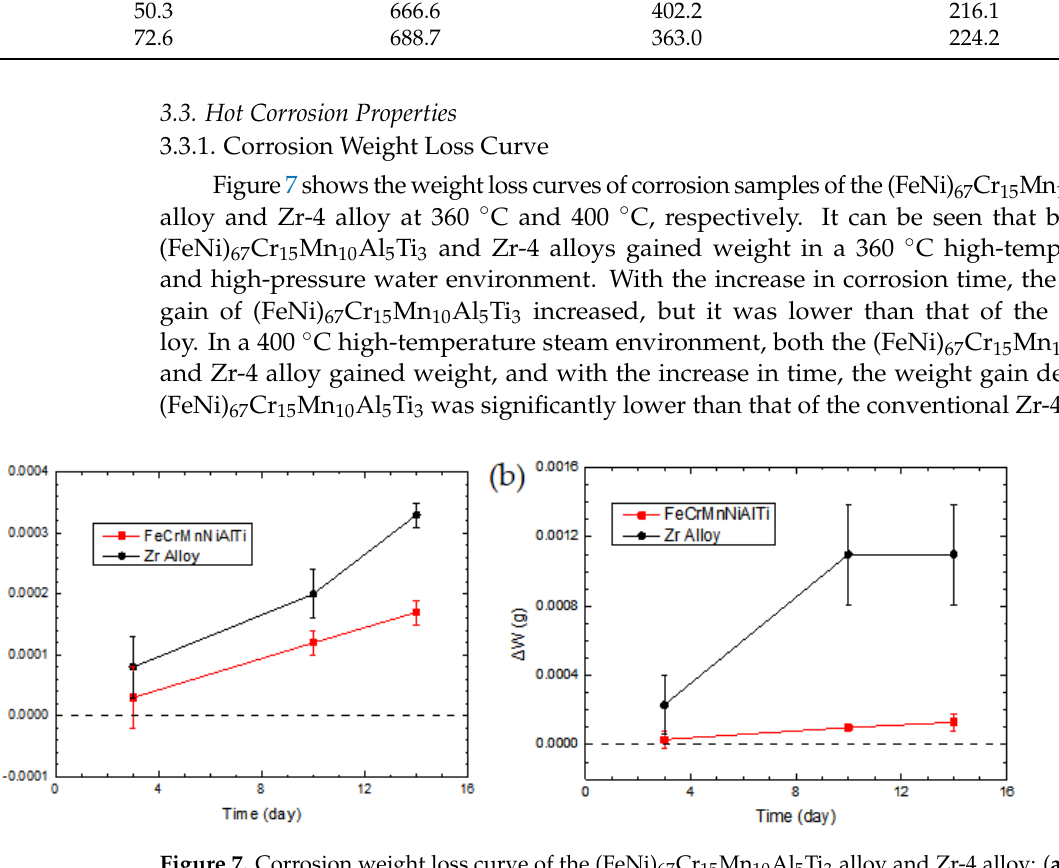
Figure 8. Microstructure after corrosion in a 360 °C high-temperature and high-pressure water environment for 14 days: ( a ) (FeNi)67Cr15Mn10Al5Ti3 alloy; ( b ) Zr-4 alloy.